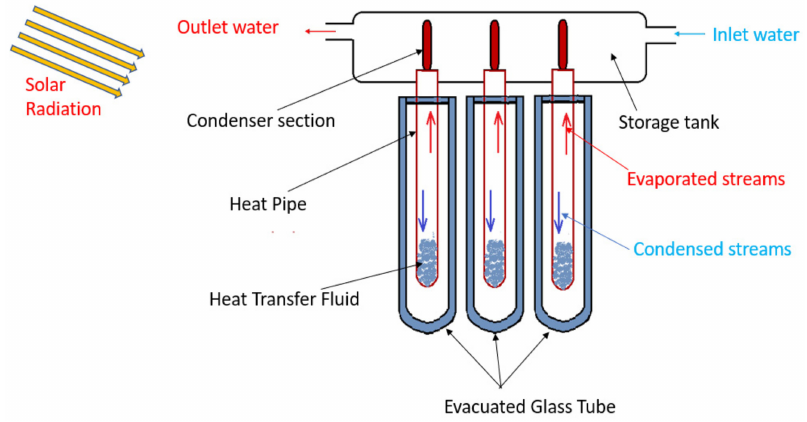
Figure 5. Schematic diagram of a heat pipe-based evacuated tube solar water